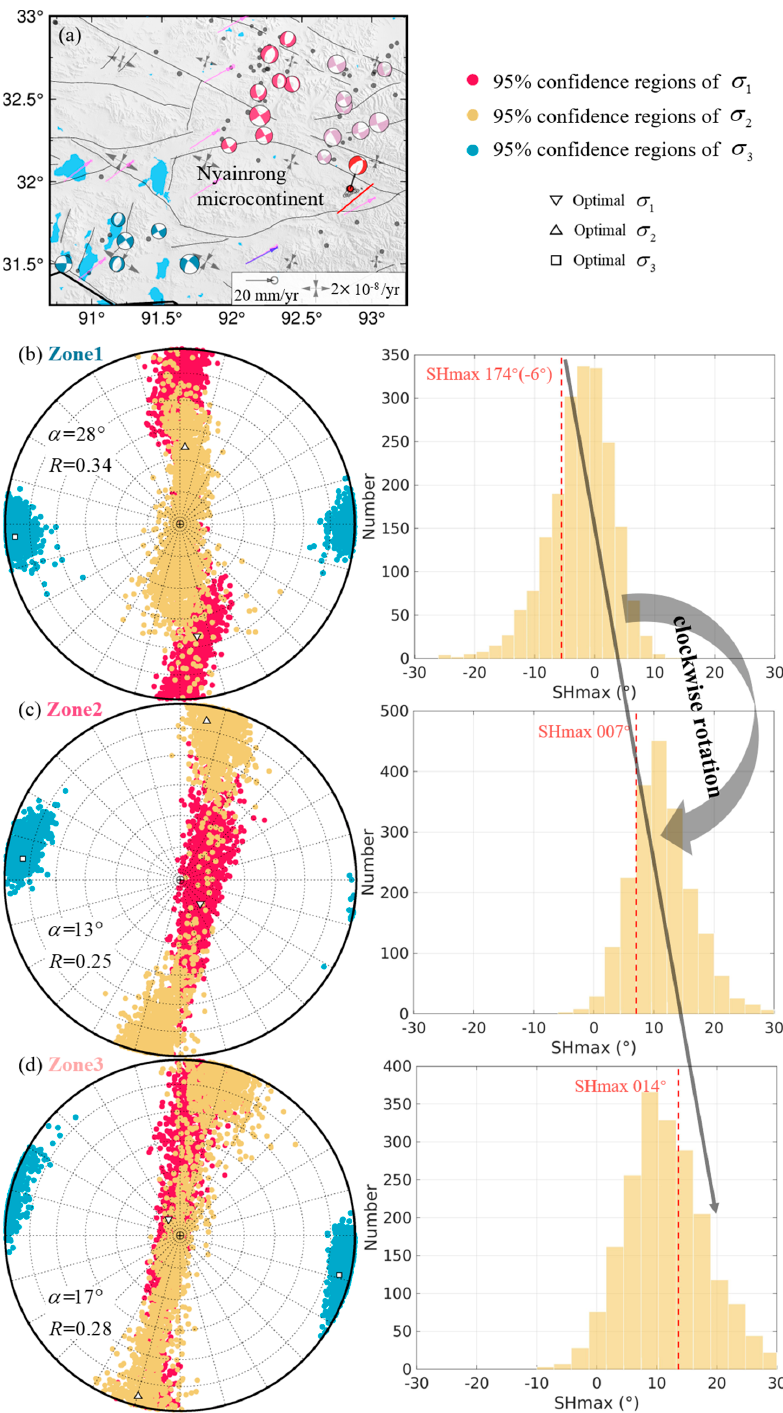
Figure 7. Stress tensor inversion. ( a ) Blue, red, and purple focal mechanisms used in the stress inversion for Zone 1 ( b ); Zone 2 ( c ); and Zone 3 ( d ), respectively. Right column shows the histograms of SHmax from 2000 bootstrap samples for three subzones, respectively. Dashed red lines are the optimal SHmax. Clockwise rotation of SHmax is discerned from Zone 1 to Zone 3. The black arrow pairs in ( a ) represent GPS-derived principal strain rates adopted from Li et al. (2021) [11]. Zone 1 is characterized by a near EW σ 1 orientation with a 36 ◦ plunge angle, a low R (0.34) value and near horizontal σ 3 (Figure 7b and Table 4). This implies that